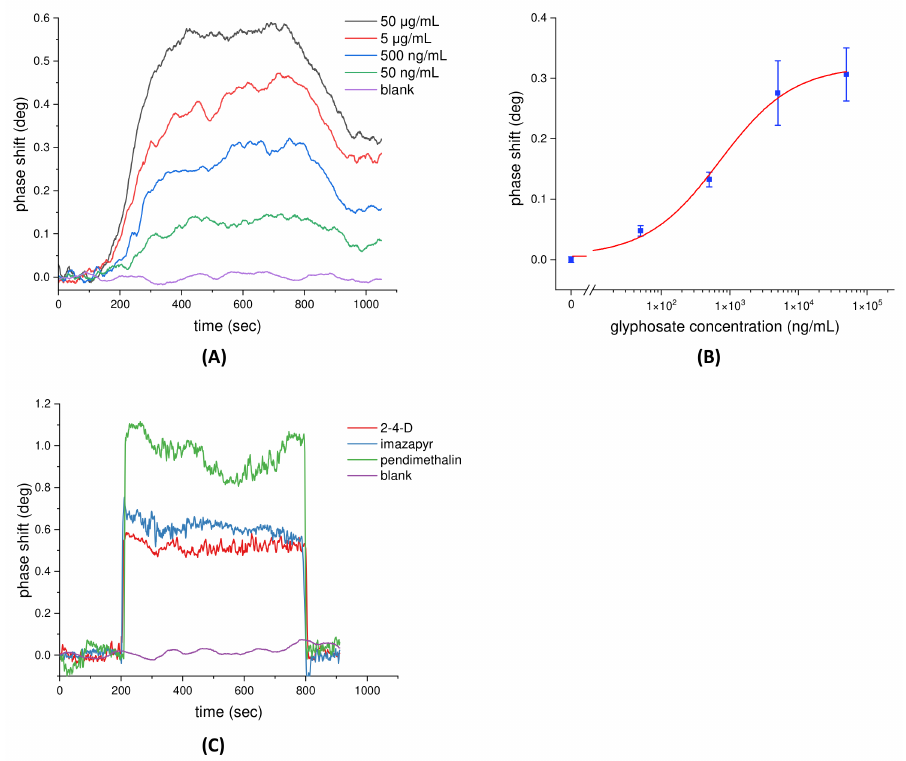
Figure 4. ( A ) The sensorgrams of glyphosate binding reaction measured by the phase-sensitive SPR sensor. ( B ) The standard curve of the glyphosate detection over the range of 50 ng/mL to 50 ug/mL. ( C ) Specificity test measured by the proposed phase-sensitive SPR